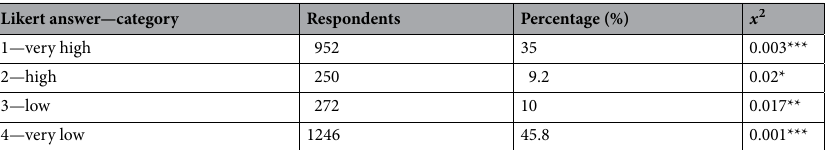
Table 3. Awareness that the government has formulated policies and measures to reduce GHG emissions. Significance level of each variable: * p = 0.1, ** p = 0.05, *** p =